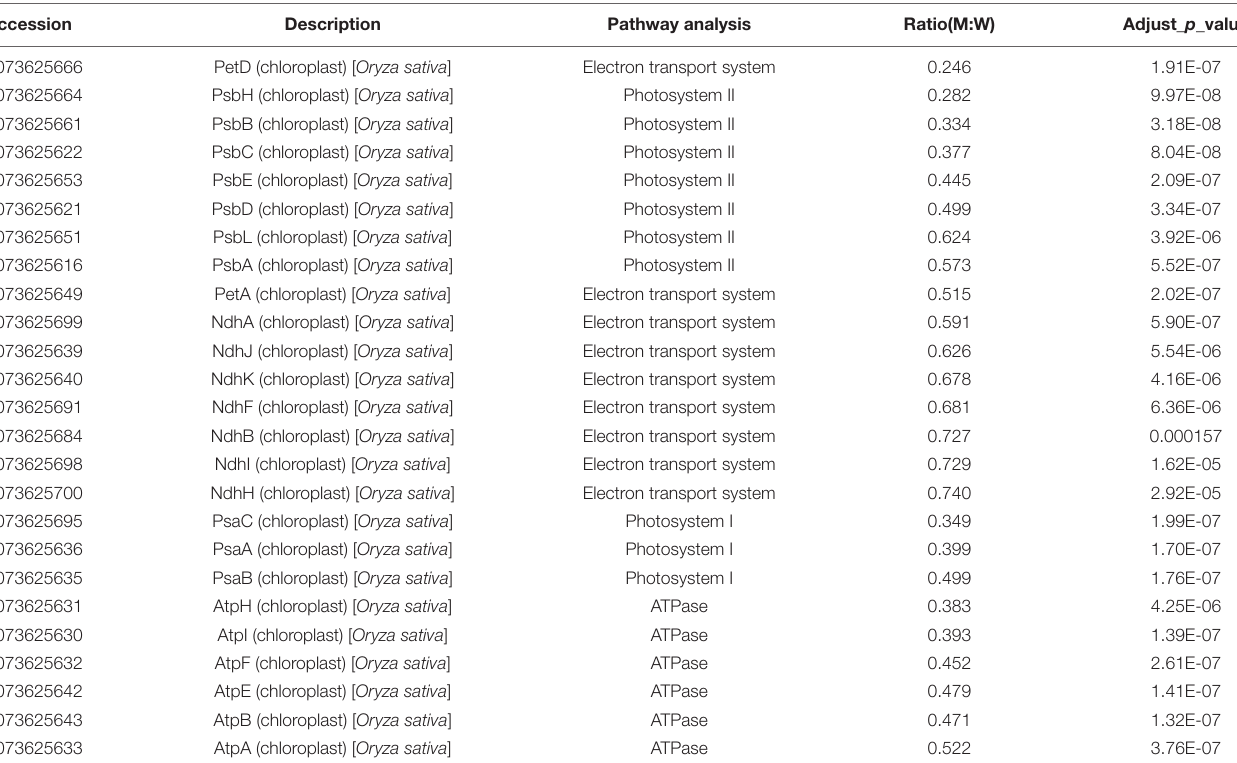
TABLE 1 | Chloroplast-encoded thylakoid protein with significant fold changes in ylc3 . Accession Description Pathway analysis Ratio(M:W) Adjust_ p _value